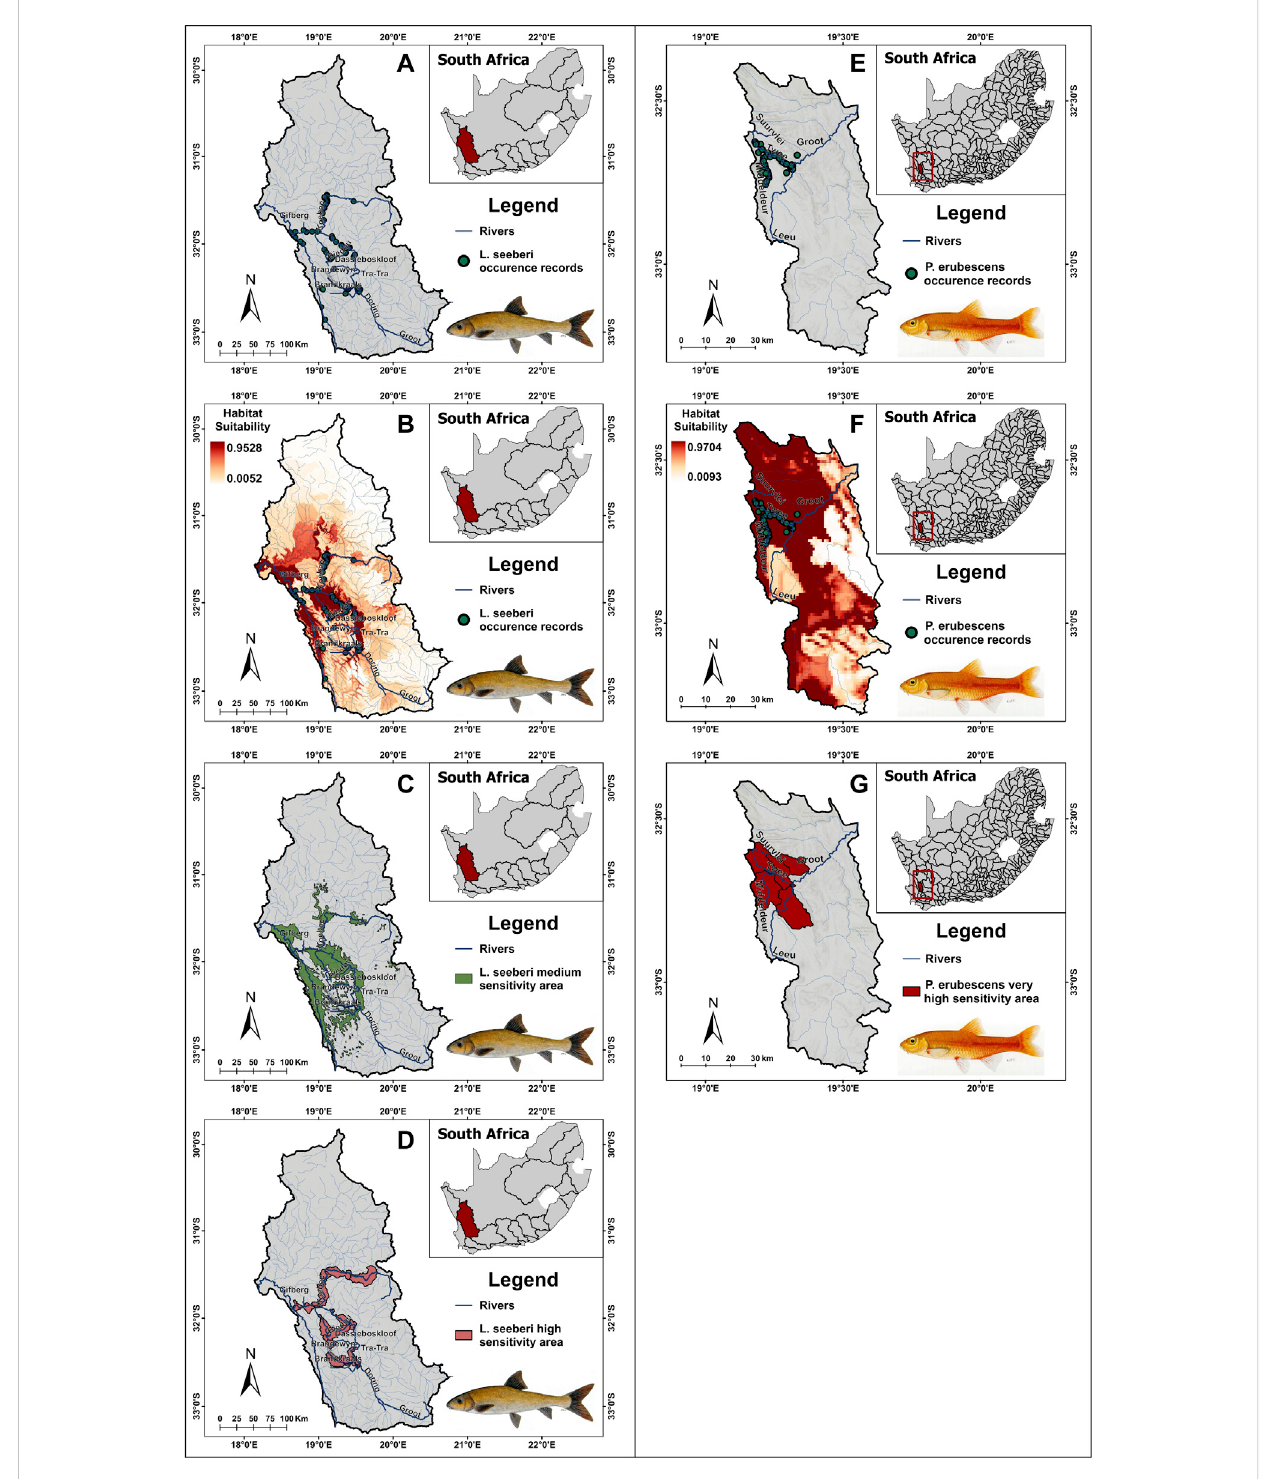
FIGURE 2 Labeoseeberi occurrencerecords (A) ,speciesdistributionmodel (B) ,mediumsensitivityarea (C) andhighsensitivityarea (D) locatedintheOlifants- DoringprimarycatchmentareaofSouthAfrica. Pseudobarbuserubescens occurrencerecords (E) ,speciesdistributionmodel (F) ,andveryhighsensitivity area (G) located in tertiary catchment